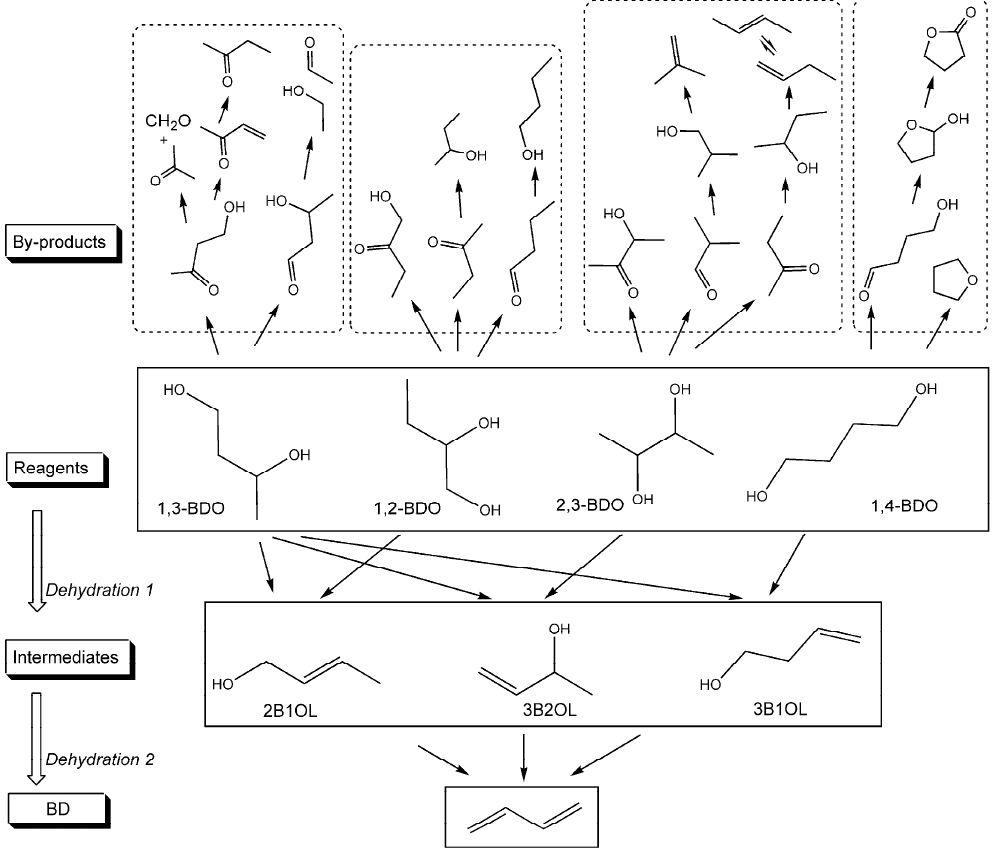
Figure 3. Synthesis of BD from butanediols (BDOs) or C4 unsaturated alcohols (UOLs) [17,62–65]. Evolution from reagents and intermediates to the target BD is labeled by arrows, and the by-products are produced during Dehydration 1.